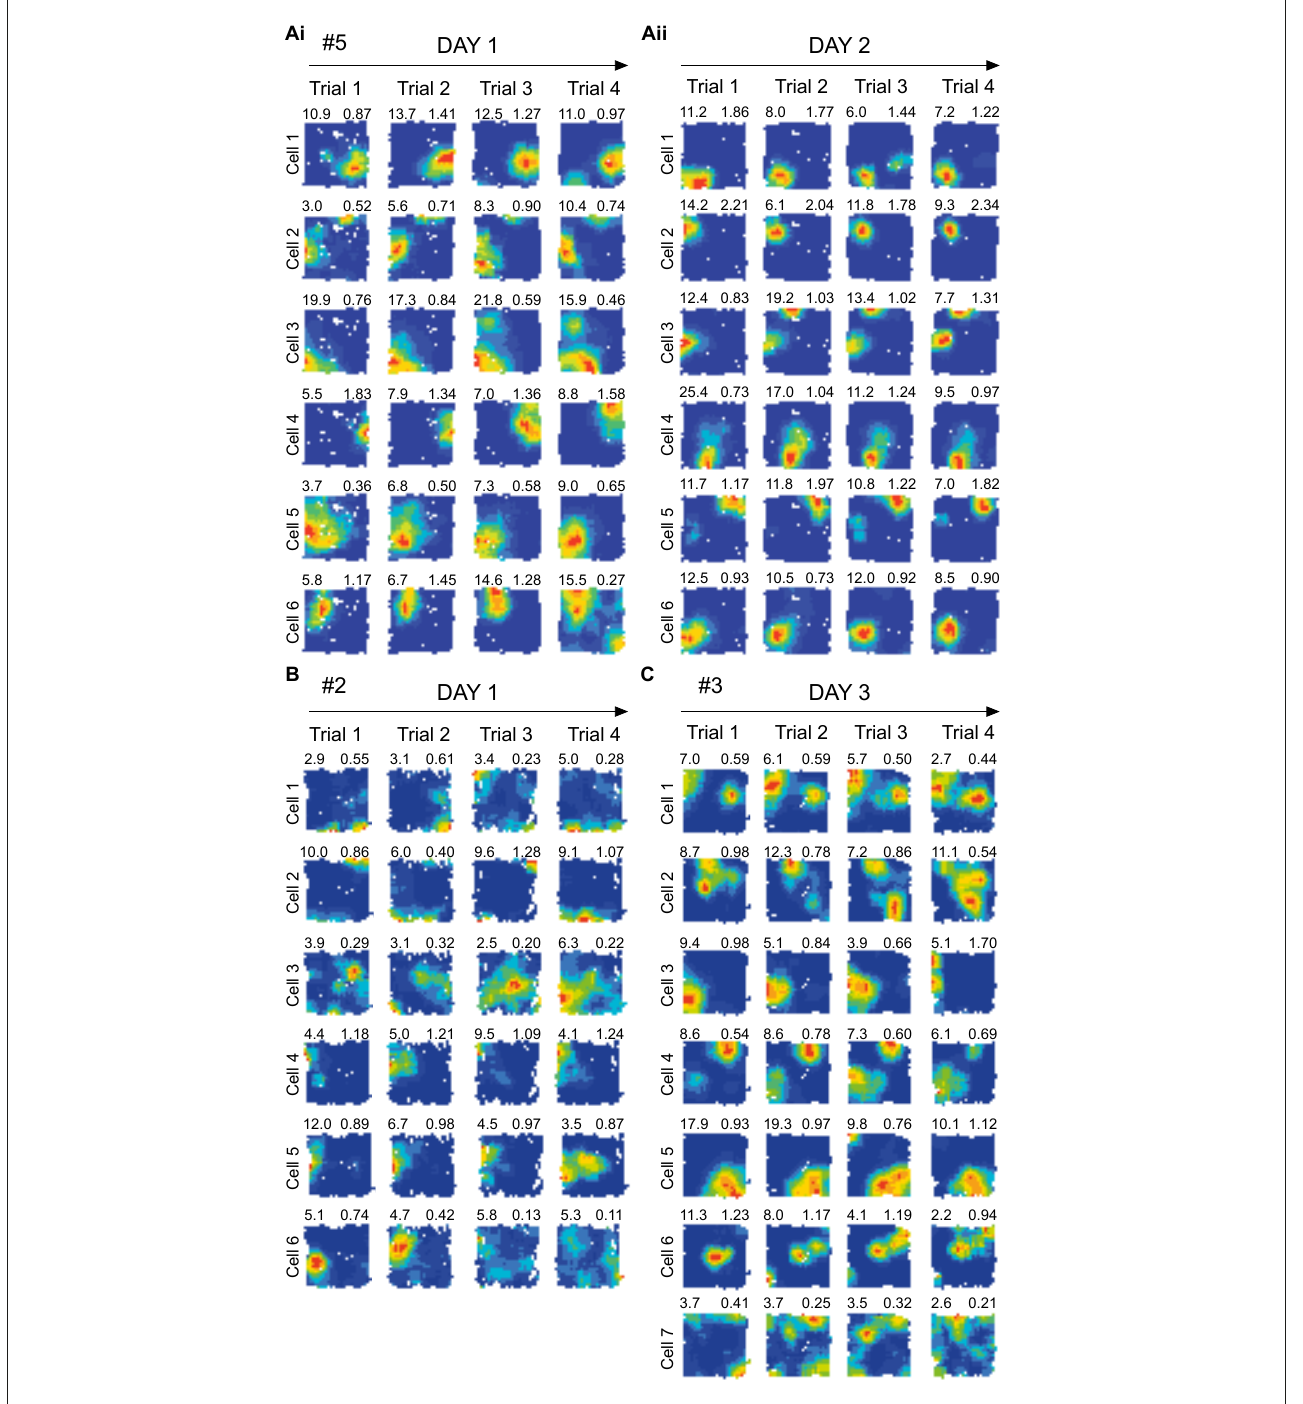
FIGURE5 Place cell firing activity during repeated exposure to the same environment. Representative dorsal. CA1 place cells recorded simultaneously from a subset of the electrodes used to record theta frequency variables shown in Figure 6 . No obvious novelty/familiarity related pattern, such as in firing rates, is observable in place cells (statistics: see Section “3.2 No significant effects of novelty in dorsal CA1 place cells” text). This is in contrast to the clear novelty/ familiarity related pattern (lower/higher frequency) seen in theta in Figure 6 . Each row shows one cell’s locational firing rate maps across trials 1–4 on a given day, with all cells shown for given rat/day combination. Arbitrary cell number shown far left of each row. Locational peak rate (Hz) shown top left, and Skaggs spatial information (bits/spike) shown top right, of each rate map. Cells recorded on Day 1 (Ai) and Day 2 (Aii) for Rat 5. (B) Cells recorded on Day 1 for Rat 2. (C) Cells recorded on Day 3 for Rat 3. # denotes rat number.